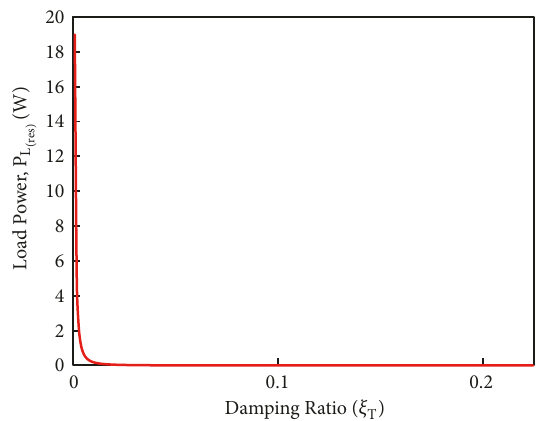
Figure 14: Load power at resonance vs. total damping ratio 𝜉 T of the